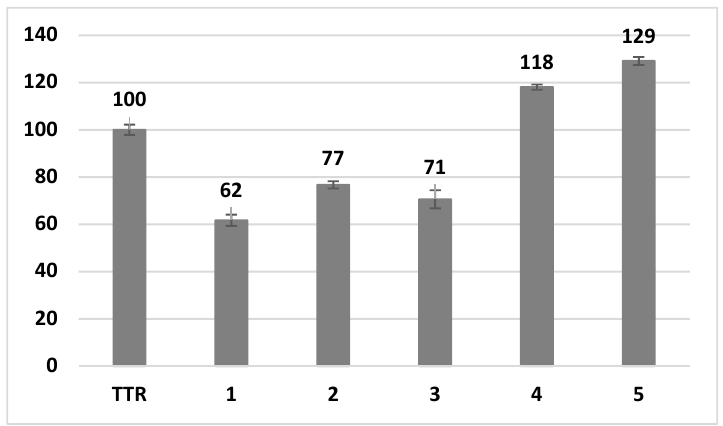
Figure 4. In vitro ThT fluorescence assay of wt-TTR in the absence or in the presence of derivatives 1 ‒ 5 . Histogram shows the percentages of aggregate formation. The fibril formation in the absence of a stabilizer was assigned to be 100%. Values represent the mean ± the standard error.